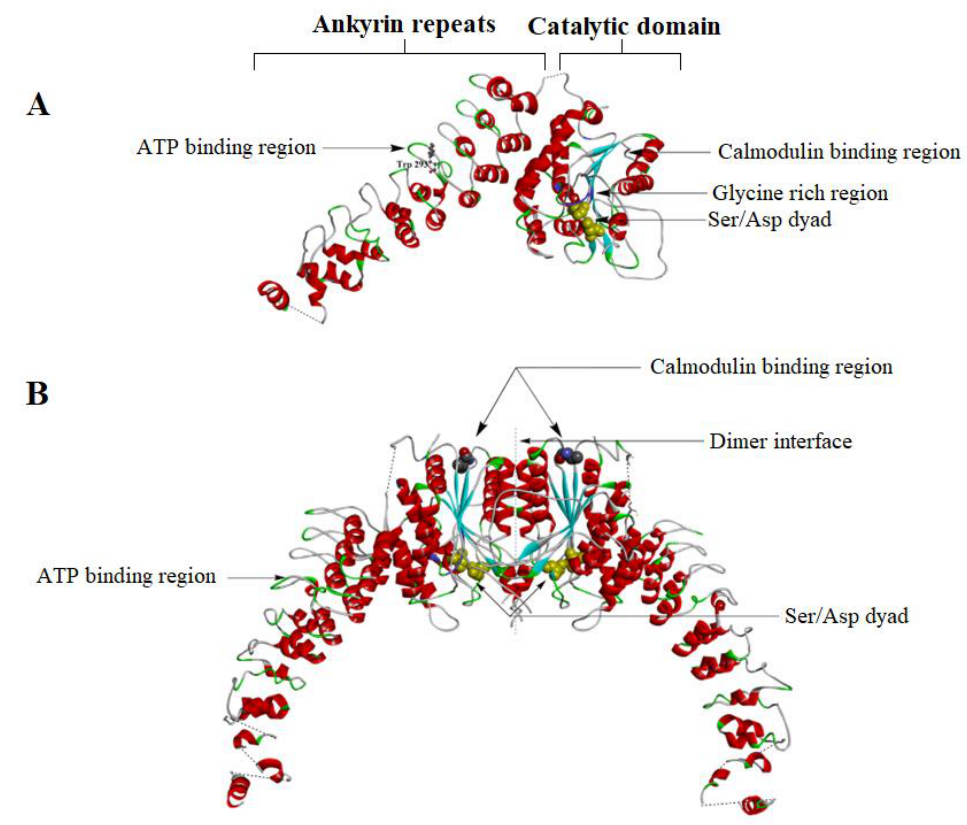
Figure 13. ( A ) The crystal structure of the monomeric form of iPLA2 β (PDB- 6AUN). The ankyrin repeats (ANK) are shown on the left side and the catalytic domain on the right side. The linker between the ANK and the CAT (connected by a dashed line) is unresolved due to less electron density. Near the 6th ankyrin repeats, there is the Trp293 residue which is believed to be the ATP binding site. The catalytic dyad (Ser465 and Asp598) is shown in purple in the catalytic domain. The glycine-rich region, which forms a rigid handle, is shown in blue. Earlier studies showed it as the ATP binding domain. The CaM binding region is near residue 630. ( B ) The dimeric structure of the iPLA2. One CaM molecule binds two iPLA2 molecules and stabilizes the close confirmation of the active sites of the enzyme. Note that the two active sites are located near the dimeric interface (Image generated using BIOVIA Discovery